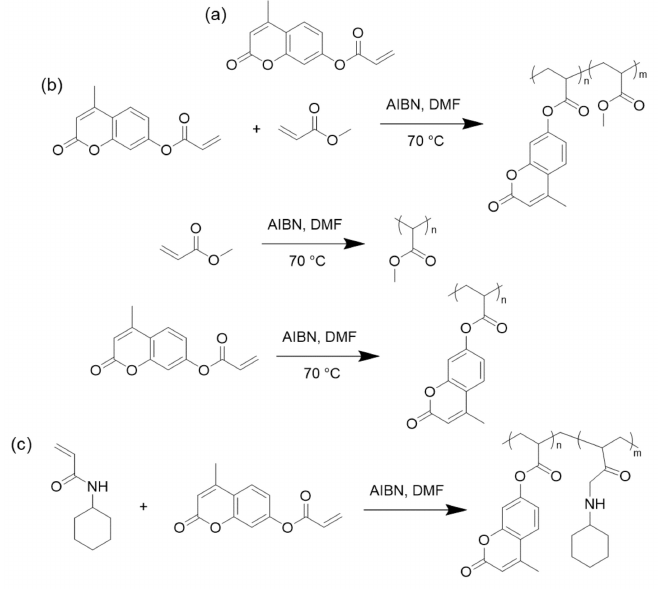
Figure 25. ( a ) Structure of 7-acryloyloxy-4-methyl-coumarin (AOMC), ( b ) synthesized (co)polymers with methyl acrylate, and ( c ) synthesized copolymer with